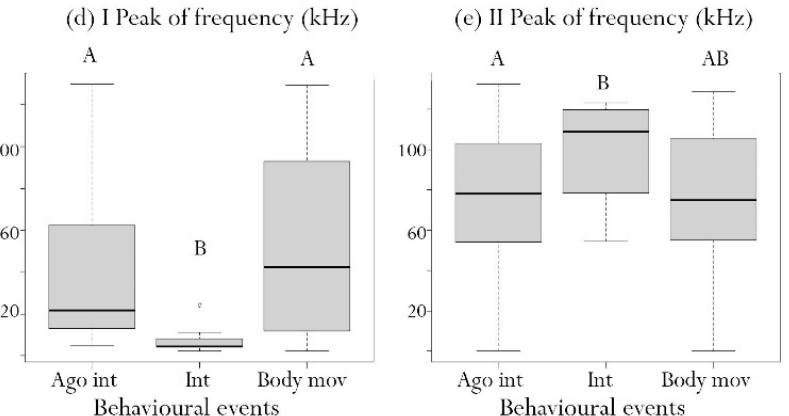
Figure 7. Comparisons of sounds acoustic parameters emitted during agonistic interaction (AgoInt), non-agonistic interactions (Int), and body movements (BodyMov) ( a ) duration, ( b ) bandwidth, ( c ) Sound Pressure Level, ( d ) I peak of frequency and ( e ) II peak of frequency. Different capital letters indicate significant differences between groups ( p < 0.05).